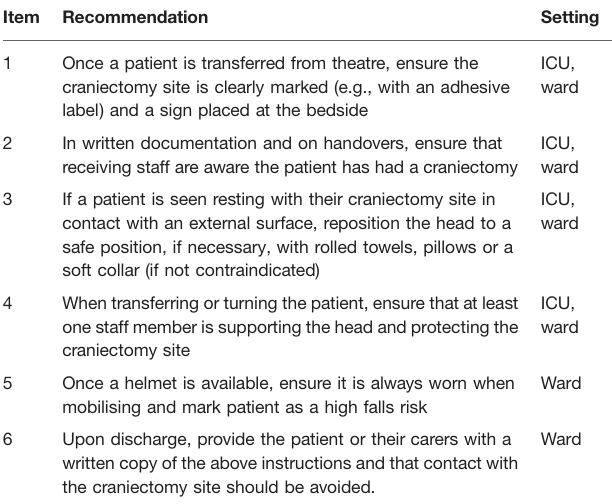
TABLE 2 | Suggested standard operating protocol for post-operative care of craniectomy